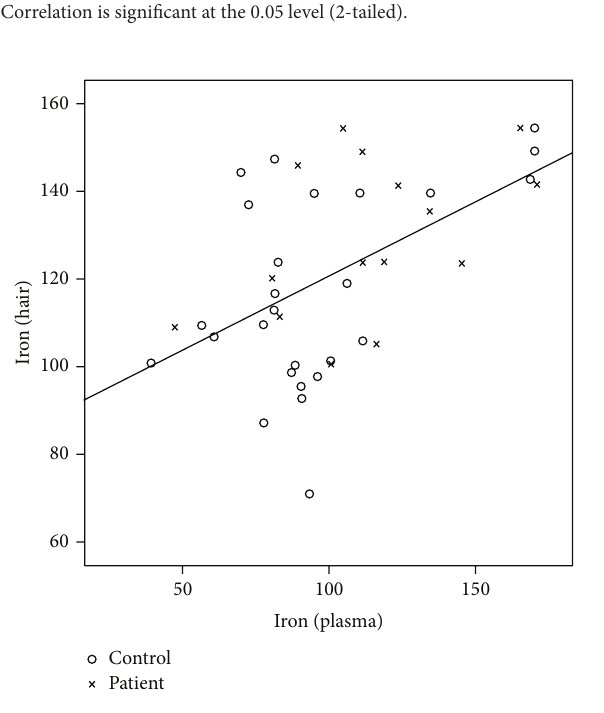
Figure 1: Correlation between plasma and hair iron level in patients and controls.